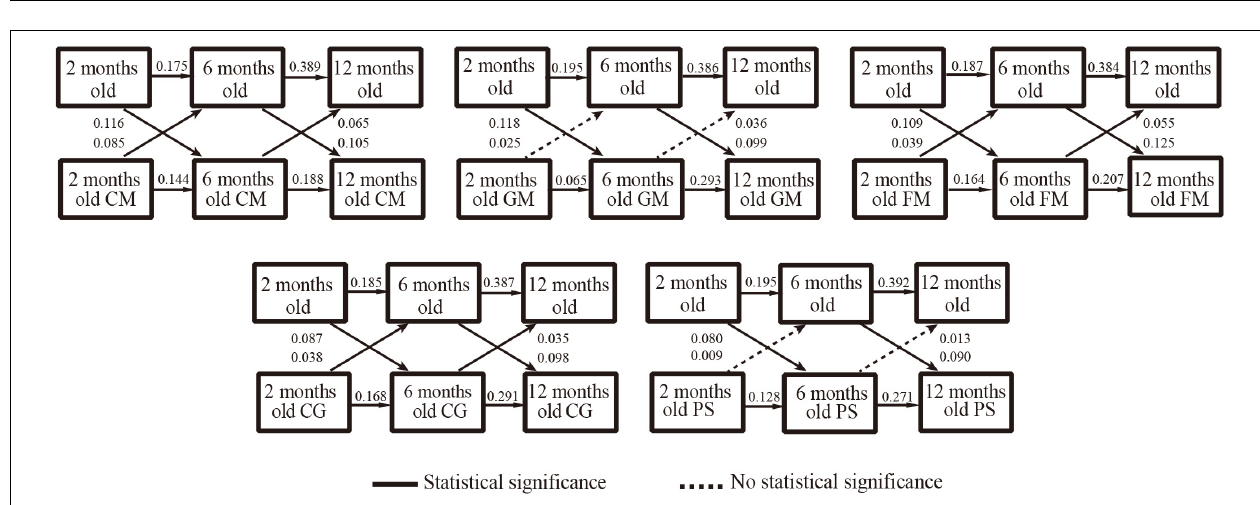
FIGURE 2 | Results of cross-lag analysis between responsive caregiving and development of infants. CM, communication; GM, gross motor; FM, fine motor; CG, problem-solving; PS, personal-social.